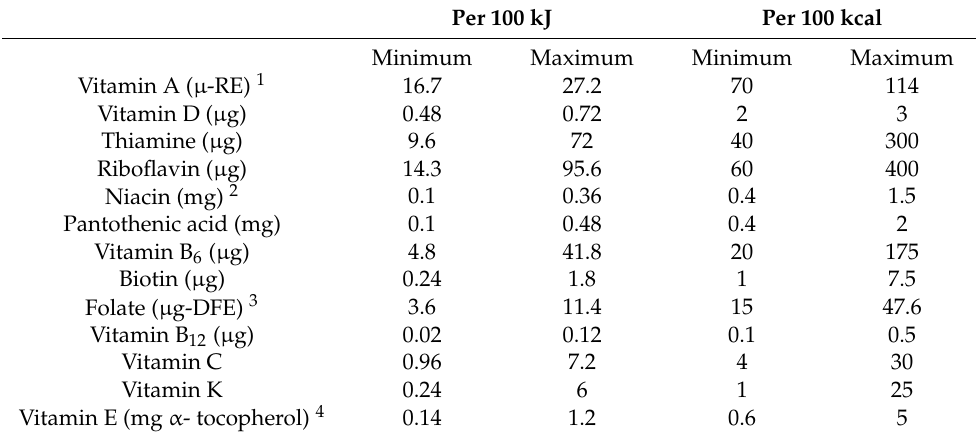
Table 5. Vitamin requirements for infant formula